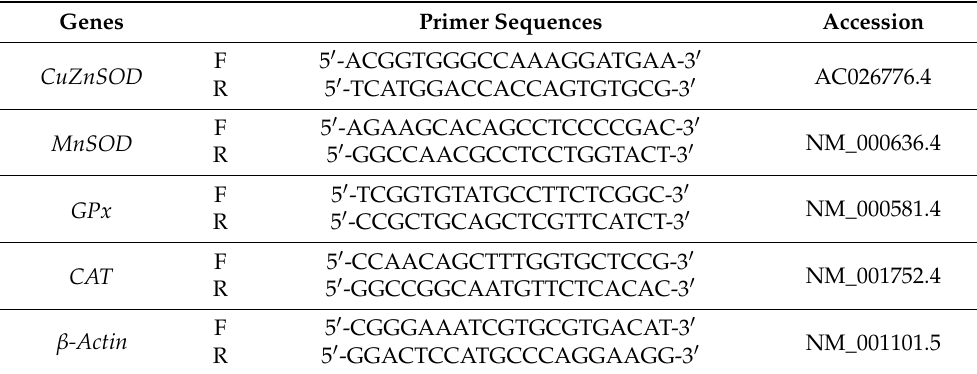
Table 1. PCR primer sequences used for quantitative real-time polymerase chain reaction (qRT- PCR) analysis.